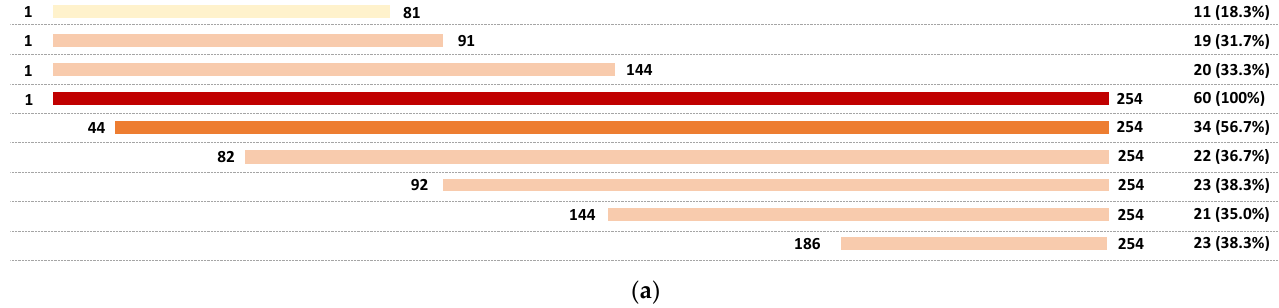
( b ) Figure 2. Epitope distribution on the Ki/SL antigen. ( a ) shows a visual representation of the recom- binant truncated fragments (and full-length) of the Ki/SL antigen and the corresponding reactivity study by Matsudaira et al. [27] (Panel ( b )) Shows the fraction of patients reacting with the recombi- nant fragments. 6. Detection Methods for Anti-Ki/SL Antibodies 6.1. Indirect Immunofluorescence Pattern of Anti-Ki/SL Antibodies The characteristic indirect immunofluorescent (IIF) staining pattern of anti-Ki/SL anti- bodies was reported to be diffuse speckled nuclear on HEp-2 cells, although some sub- strates showed nucleolar staining as well [29] (Figure 3). Interestingly, antibodies to PA28a showed cytoplasmic staining, which is consistent with the reported localization of the protein and also with the moderate (~40%) homology between Ki/SL and PA28a, as the cognate antibodies are apparently not cross-reactive [30]. More specifically, although 13/27 (48%) of anti-Ki/SL also reacted with PA28a, it is unlikely that this represents cross- reactivity. Until the present, only one study that investigated the reactivity of anti-PA28a and anti-Ki/SL in the same cohort of patients [30] found that the prevalence of the two autoantibodies was comparable. Anti-Ki/SL antibodies have not been addressed by the International Consensus of ANA Patterns (ICAP) [31]; however, the described pattern is similar to AC-04 and/or AC-05. Along those lines, it is of relevance that more and more sub-patterns are being added to the consensus list [32]. Interestingly, anti-Ki/SL antibodies frequently occur at high titers, both using IIF as well as solid-phase assays, such as ELISA (unpublished data).